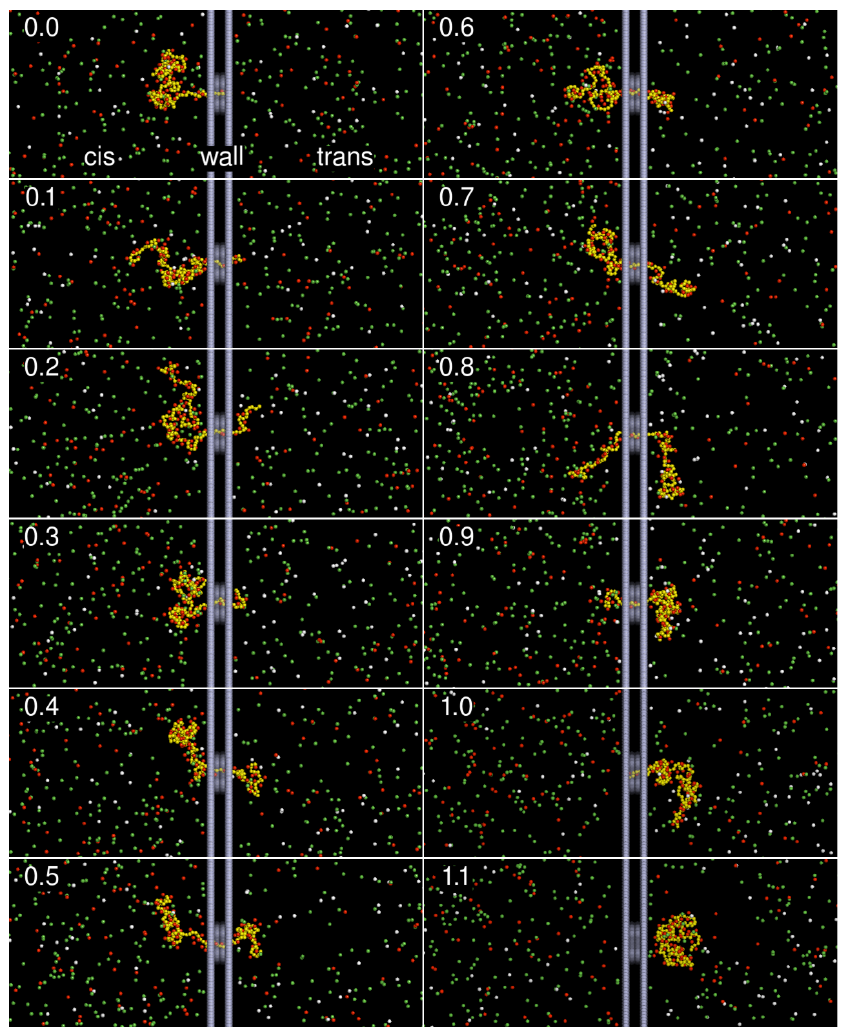
Figure 3. Snapshots of a threading process. The polyelectrolyte is represented by a yellow bead-spring chain. The divalent counterions, monovalent counterions and coions are represented in the red, white and green beads, respectively. A hallow wall separates the space into the cis and trans regions, connected by a pore channel at the center. A driving electric field (cid:126) E = − E ˆ x is applied inside the pore. In the snapshots, the chain length is N m = 128, and E is 0.5. The number on the left-top corner of each snapshot indicates the progress of the translocation, defined as the ratio of the elapsed time over the translocation time. To visualize the chain inside the pore, the wall beads (in gray color) have been plotted with certain degree of